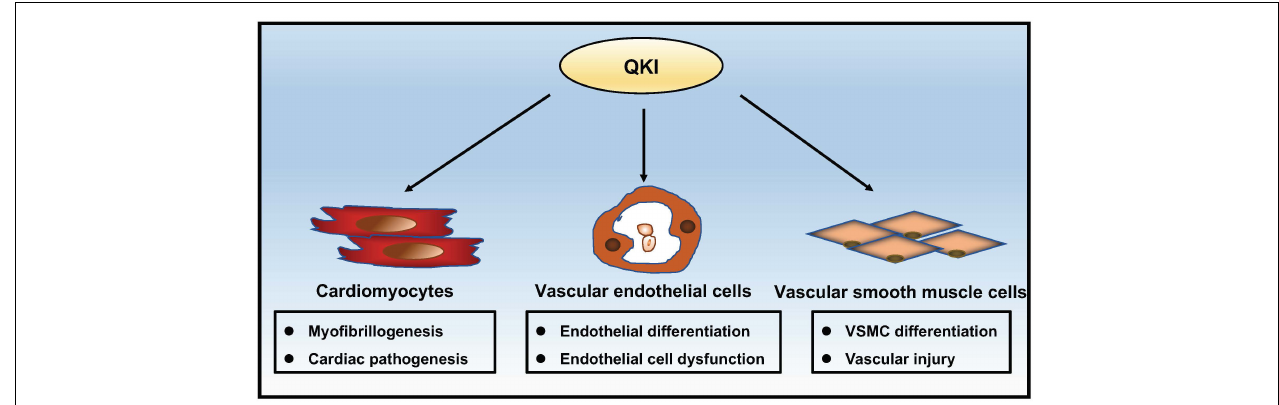
FIGURE 2 | Schematic summary of the complex roles of QKI in cardiac and vascular development and function.